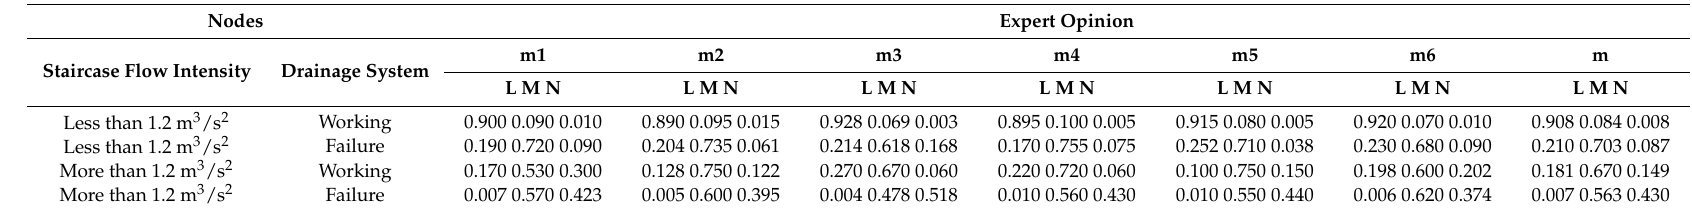
Table 3. Experts’ CPT scores of “Economic loss”